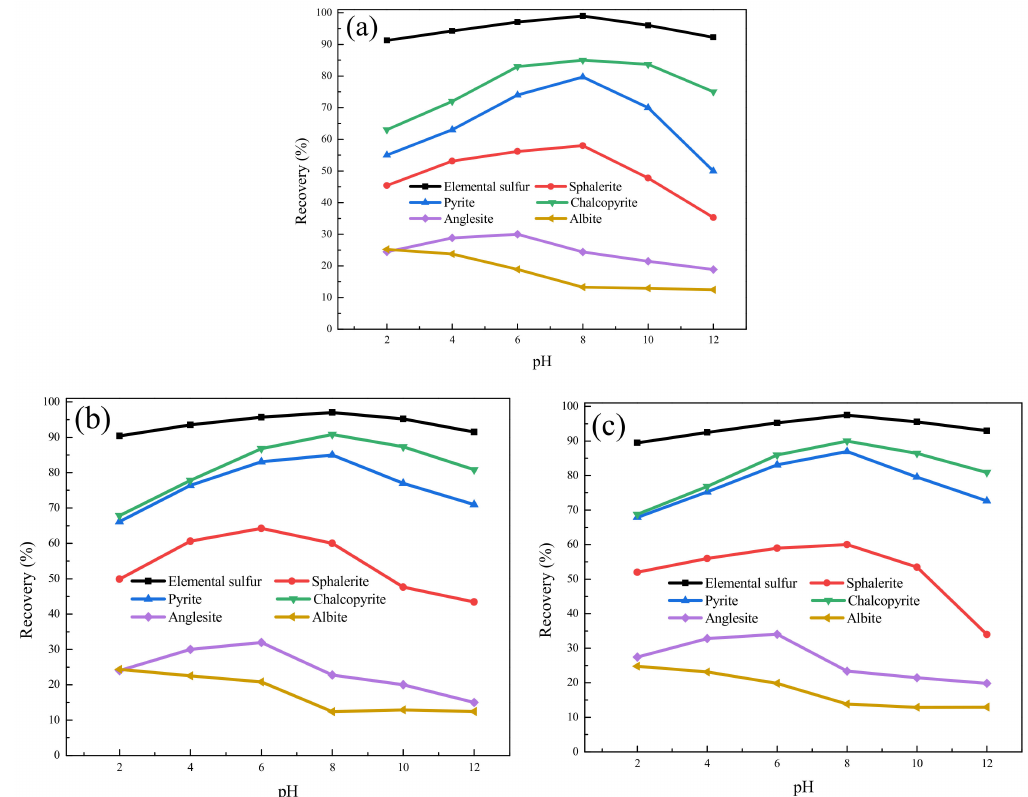
Figure 4. Effect of pulp pH on pure mineral recovery at optimum collector dosage (( a ) IPETC; ( b ) ADDTP; ( c )